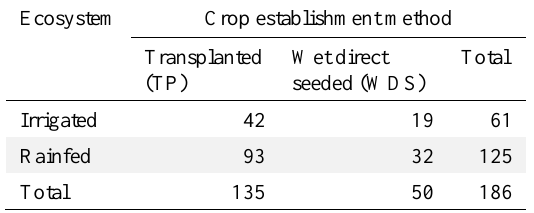
Table 3. Distribution of rice fields surveyed by ecosystem and crop establishment method, 2018 wet